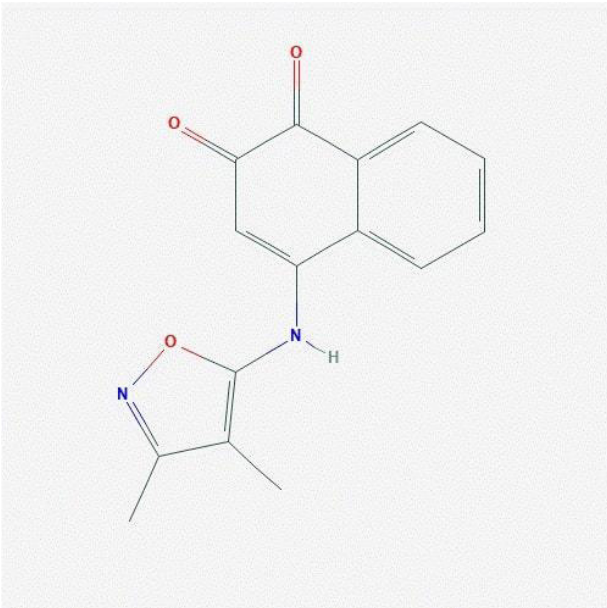
FIGURE 1D - Naphthoquinone is the major bioactive compound isolated from the alkanet plant. It was found that some naphthoquinone compounds have anticancer activity, but information about the structuralfunctional relationship of naphthoquinone compound is